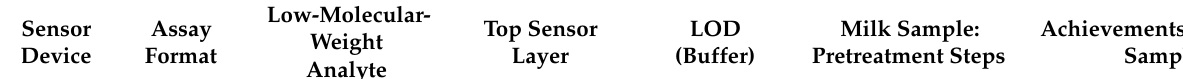
Table 3. Detection of low-molecular-weight compounds ( M r < 500) in cow’s milk using competitive and binding inhibition assays with QCM and SAW